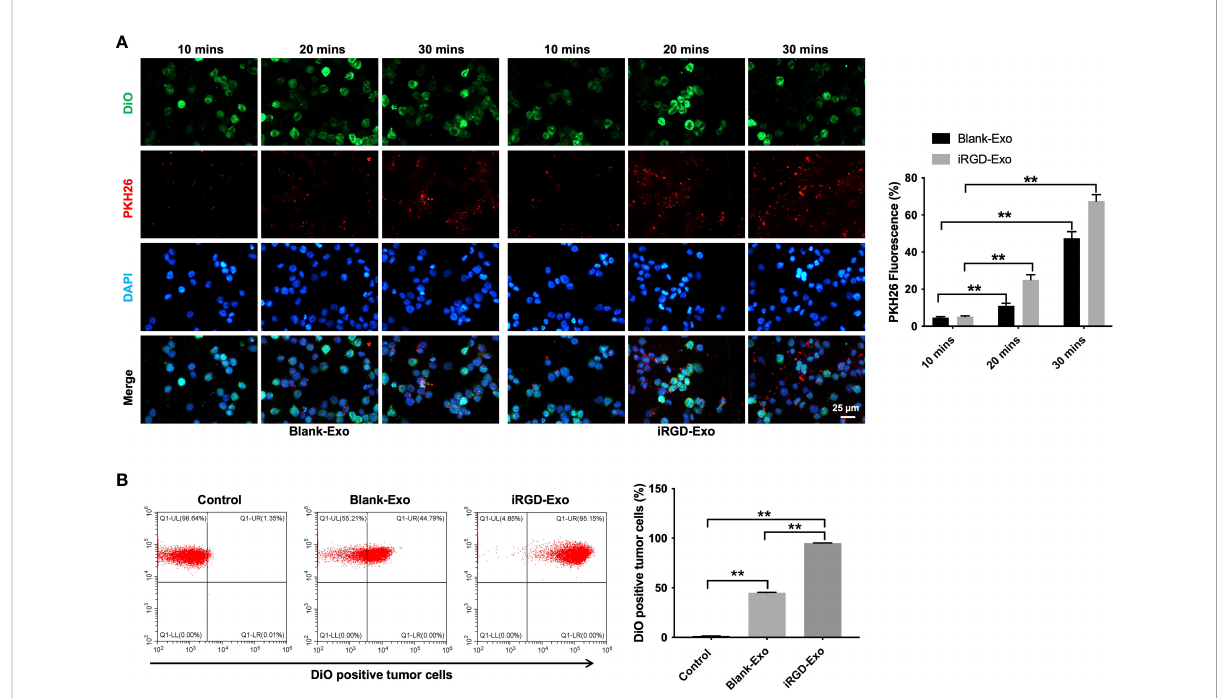
FIGURE 3 Targeting DLBCL cells via iRGD-Exo. (A) Confocal microscopy images of colocalization of exosomes in OCI-Ly8 cells. Nucleus was stained with DAPI (blue), cell membrane was stained with DiO (green), exosomes were labeled with PKH26 (red). Scale bar, 25 m m. (B) Flow cytometry analysis of the proportion of OCI-Ly8 cells that were bound to iRGD-Exo. **P < 0.01. All tests were repeated in triplicate.